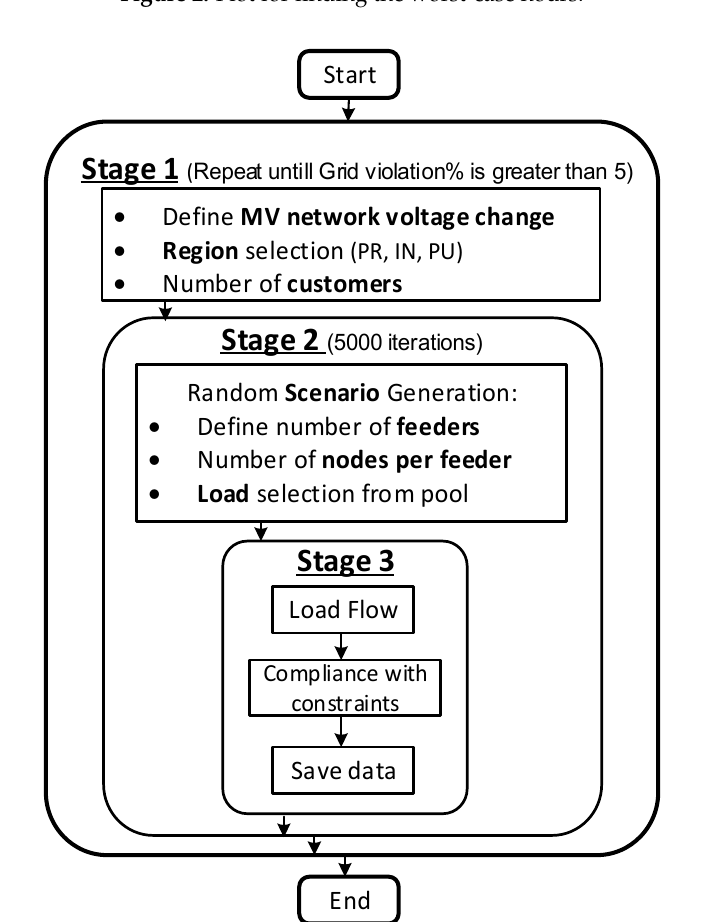
Figure 3. Monte Carlo based algorithm for test network generation, MV represents medium voltage.